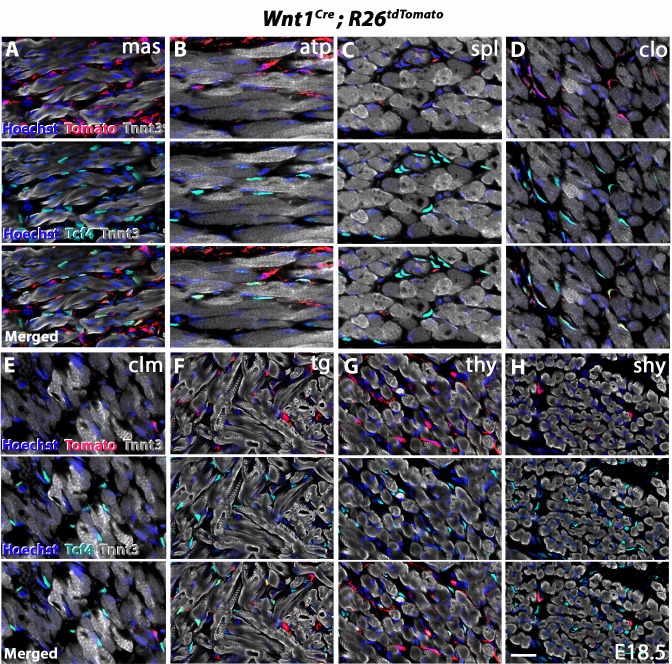
Wnt1 lineage contribution to connective tissue fibroblasts.Immunostainings of coronal cryosections (n = 2) show selected muscles analysed in Figure 3 and Figure 3—figure supplement 2 including the masseter (A), acromiotrapezius (B), splenius (epaxial) (C), cleido-occipitalis (D), cleidomastoid (E), tongue (F), thyrohyoid (infrahyoid) (G) and sternohyoid (infrahyoid) (H). Note only little or no NCC contribution to cleidomastoid, infrahyoid and epaxial muscles. atp, acromiotrapezius; clm, cleidomastoid; clo, cleido-occipitalis; mas, masseter; shy, sternohyoid; spl, splenius; tg, tongue; thy, thyrohyoid. Scale bar in H for A-H 20 µm.